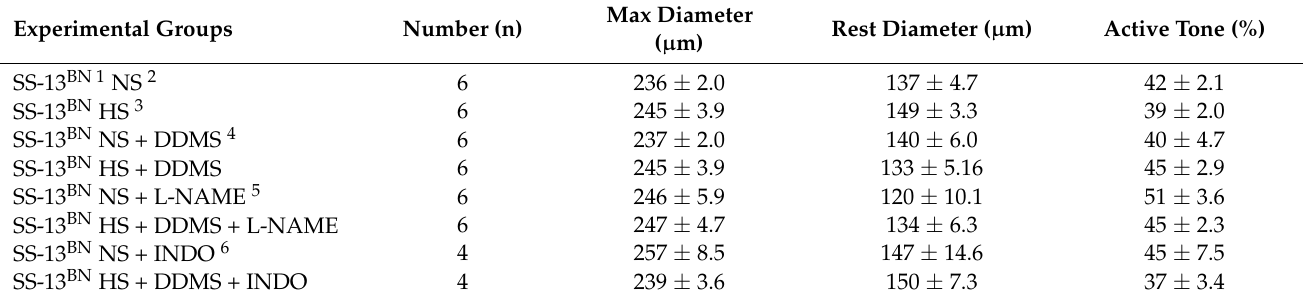
Table 1. MCA Diameters and Resting Tone in SS-13 BN Consomic Rats.